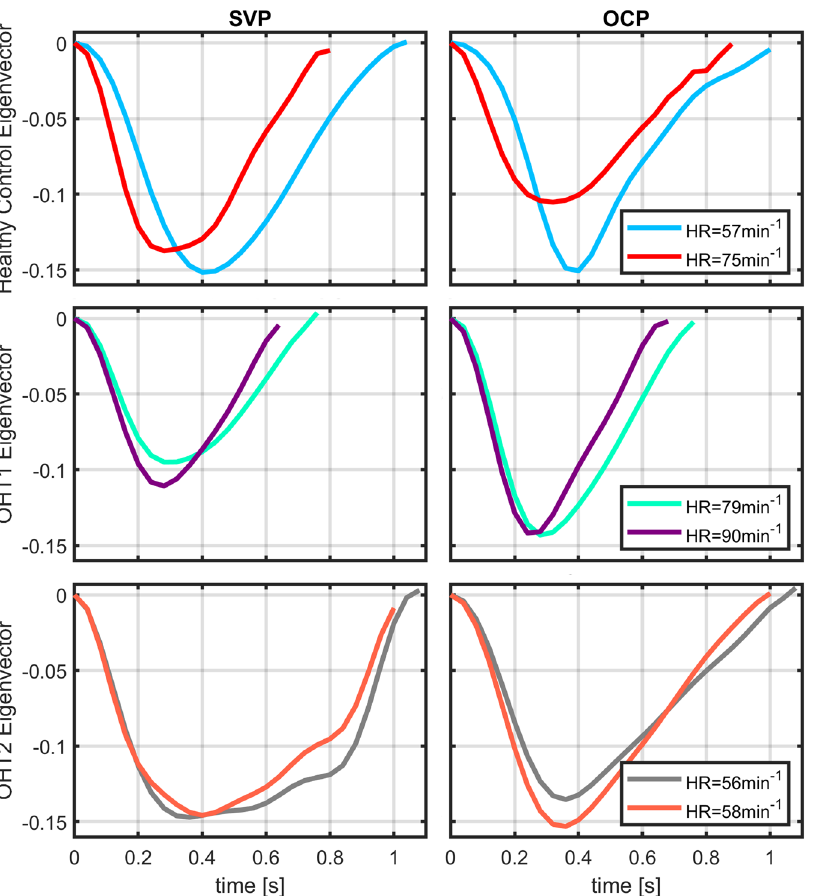
Fig. 4 Representative examples of heart rate (HR) dependent intra-participant variability of retinal pulsatile patterns in one healthy control and two medicated ocular hypertension (OHT) patients. For each participant, one retinal video-recording (RVR) was acquired with the monocular video- ophthalmoscope (VO) utilizing the CCD camera chip and one with the binocular VO utilizing the CMOS camera chip. The between-acquisition time interval was about two years for each representative participant. In healthy control and one OHT participant (OHT1), intra-participant RPP morphologies were dissimilar at different HR while RPP morphology remained unchanged for comparable HR as captured for other OHT participant (OHT2). Another OHT participant had different HR over acquisitions with similar outcomes as presented for the OHT1 participant. SVP spontaneous venous pulsations, OCP optic cup pulsations, HR heart